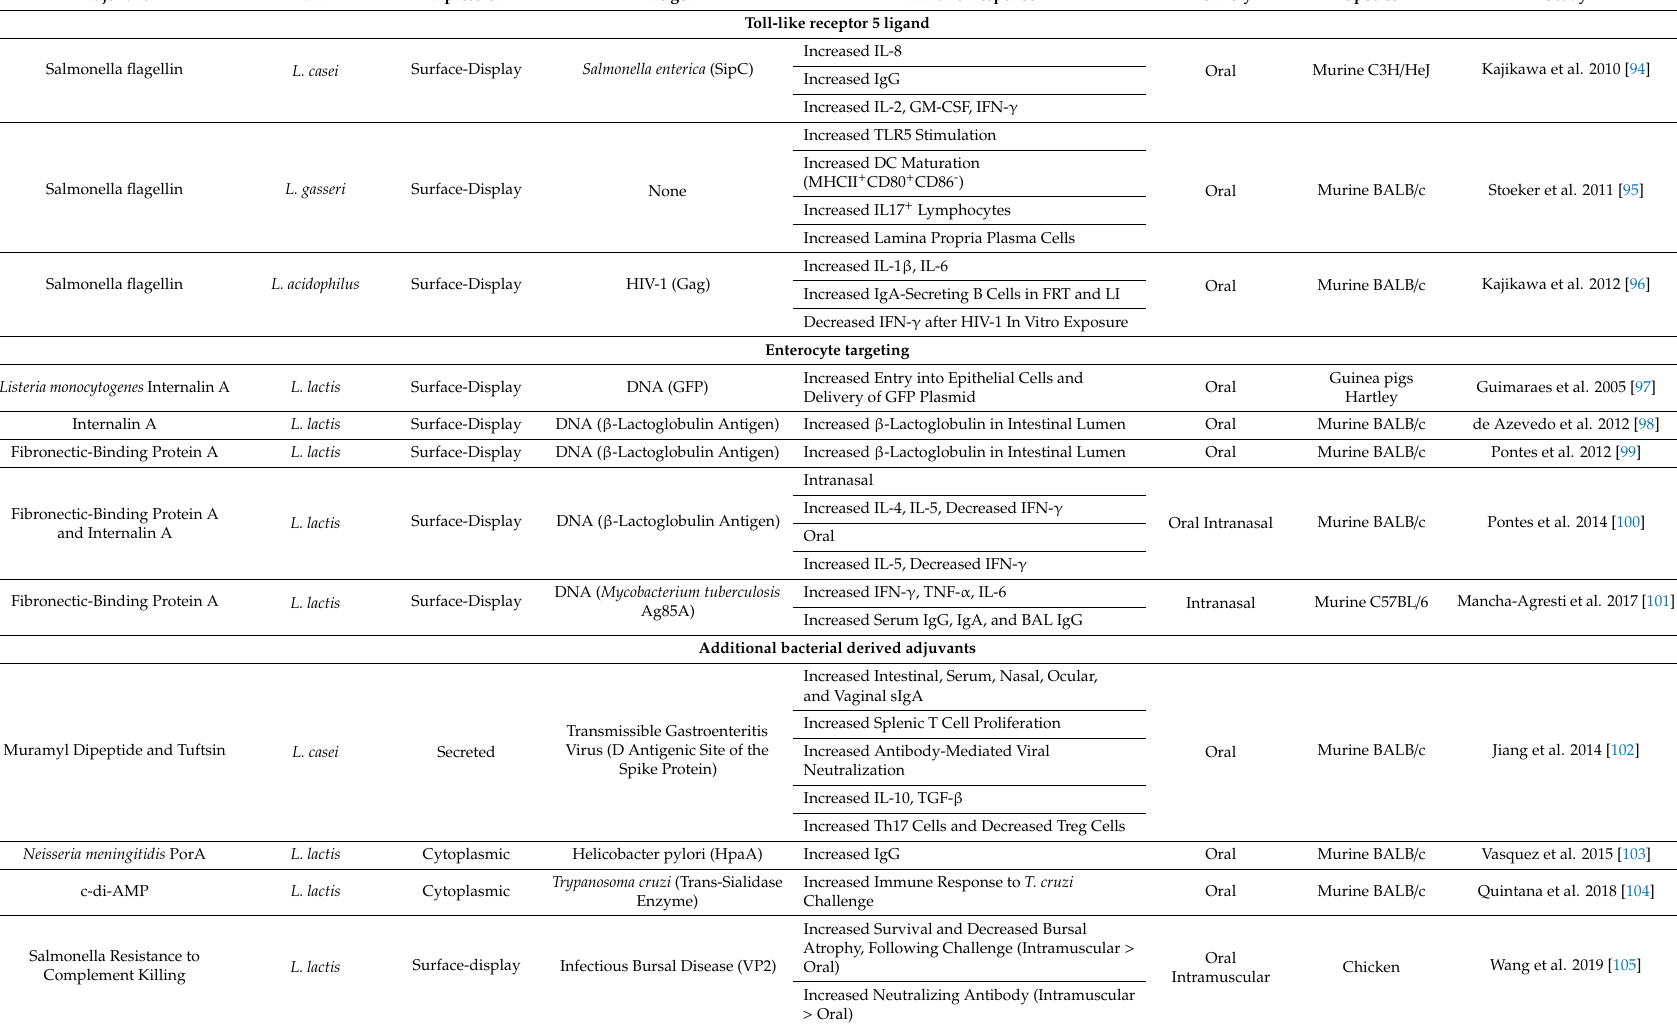
Table 4. Bacterial derived adjuvant strategies for lactic acid